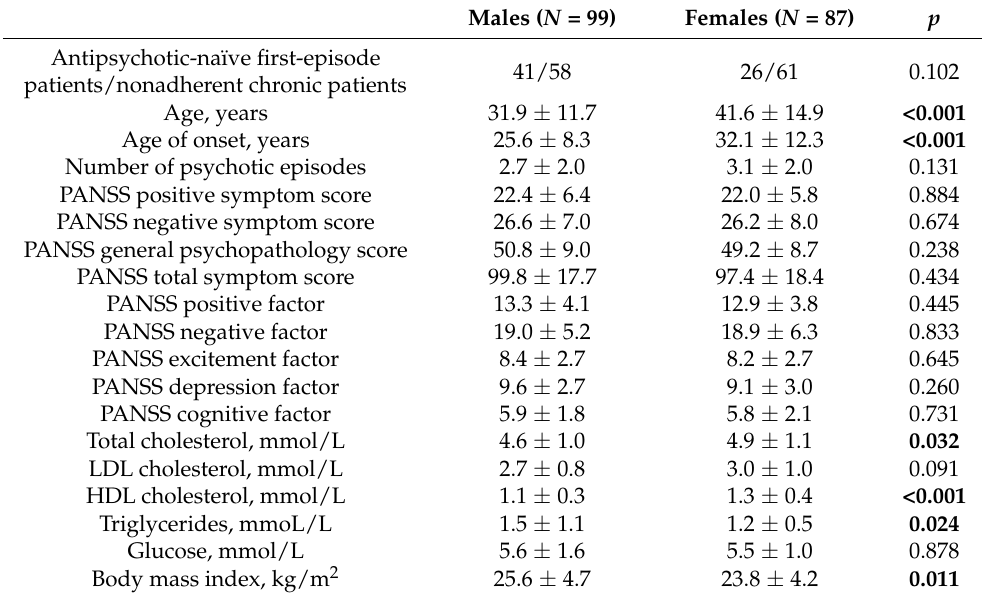
Table 1. Patients’ characteristics at baseline.